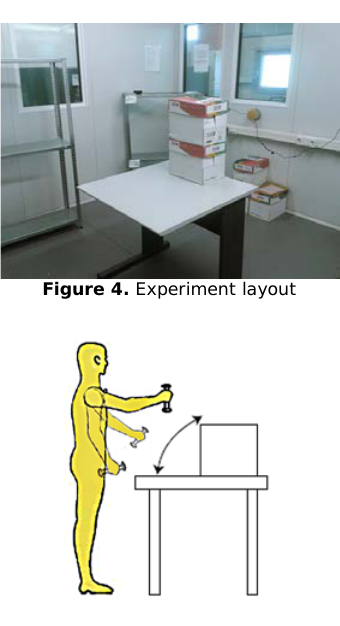
Figure 3. Calibration Object